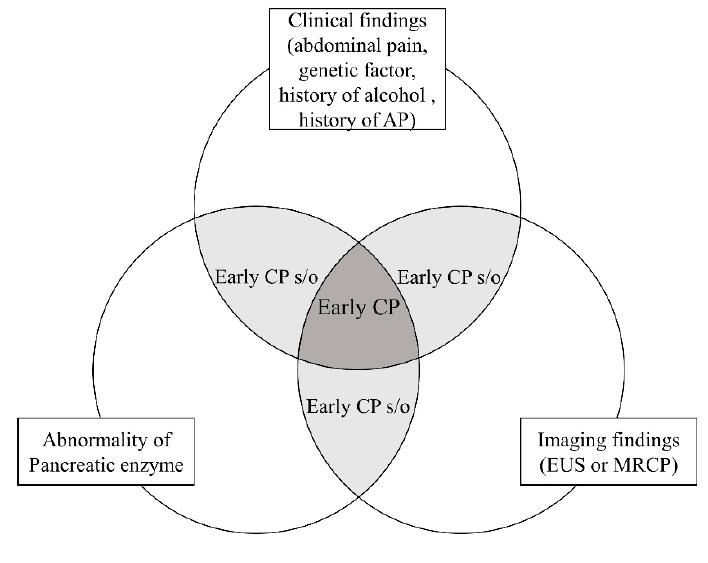
Figure 3. The concept of early CP.